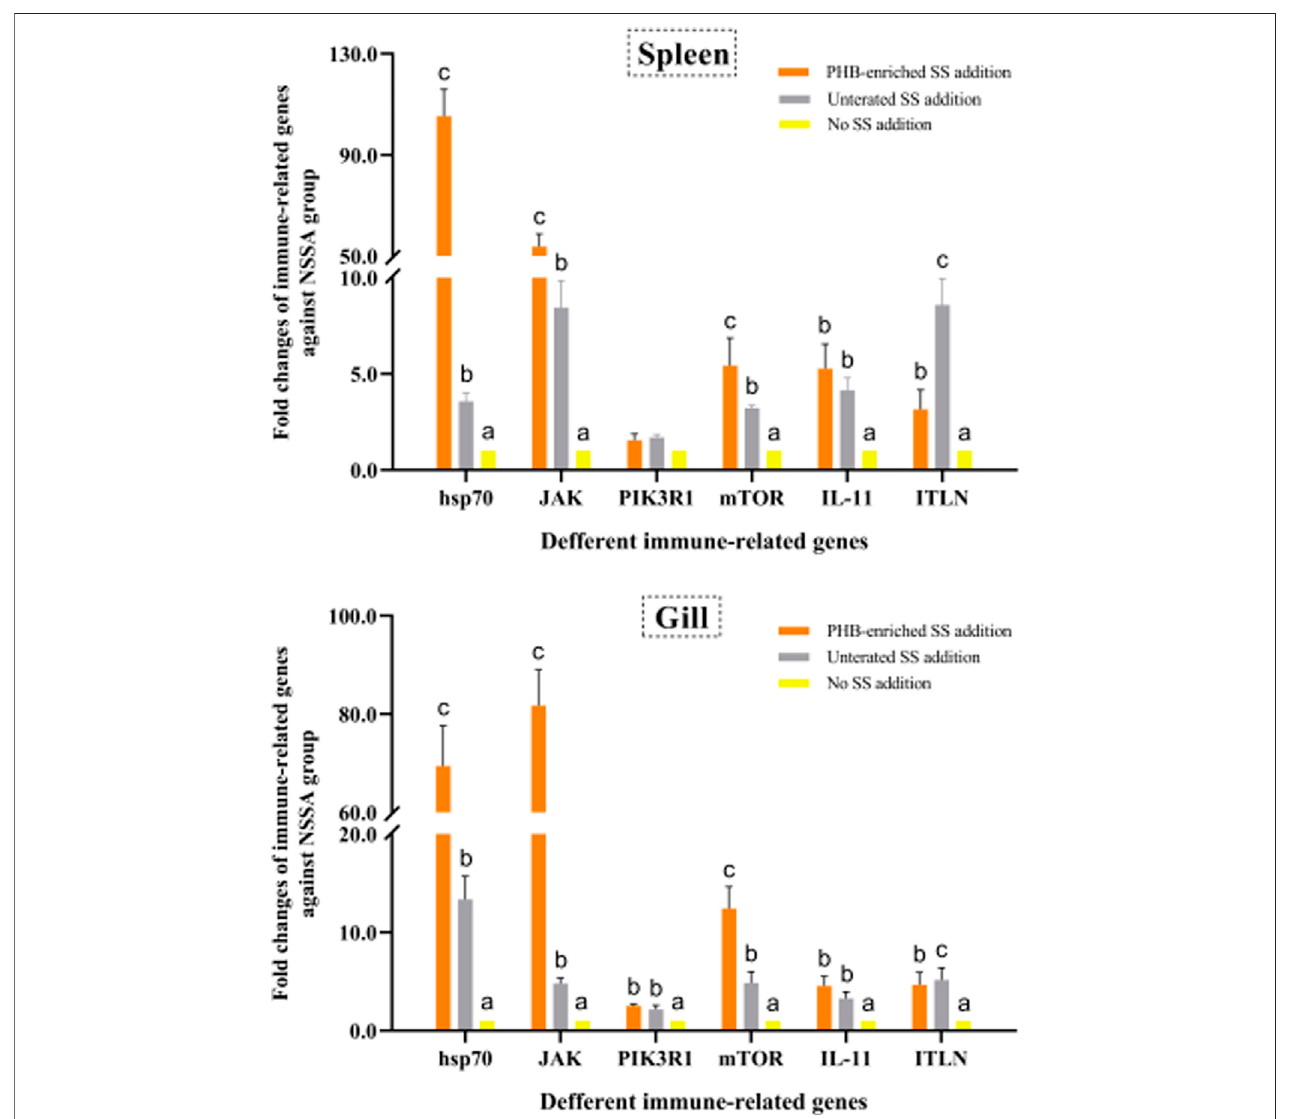
FIGURE 7 | Effects of PHB-IRenriched and untreated SS addition in culture water on the immune-related gene expression in the spleen and gills of gibel carp ( Carassius auratus gibelio ).